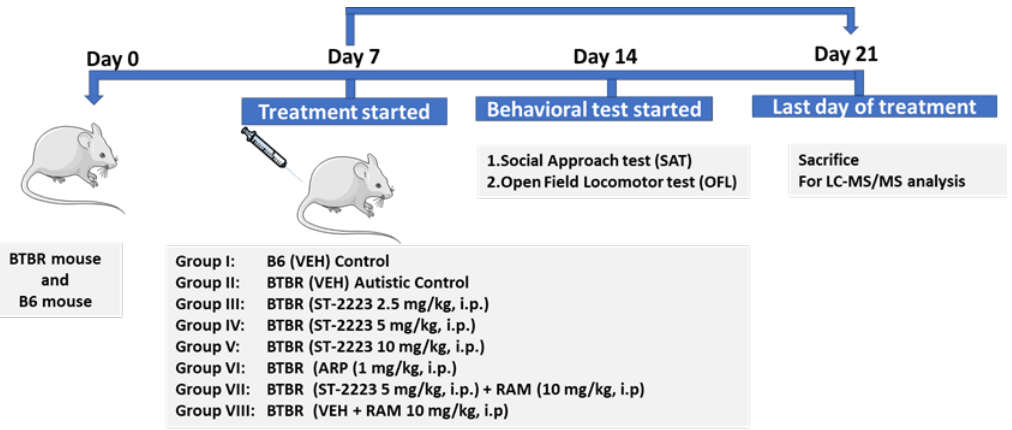
Figure 7. Schematic experimental design .